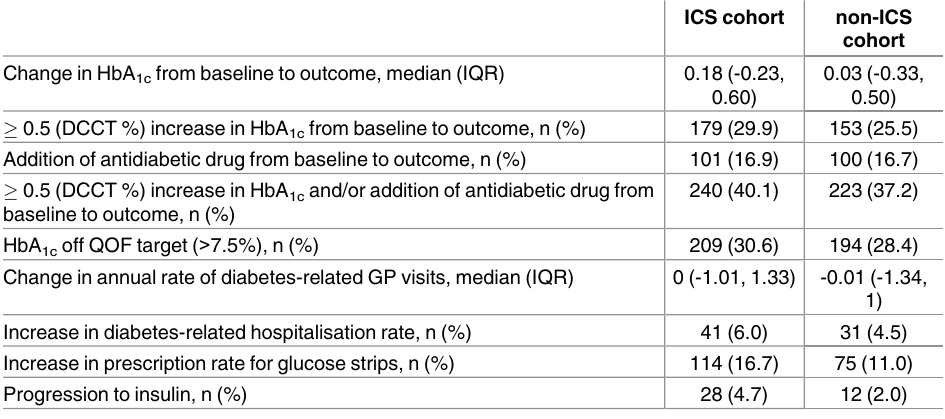
Table 3. Study endpoints during the outcome year.